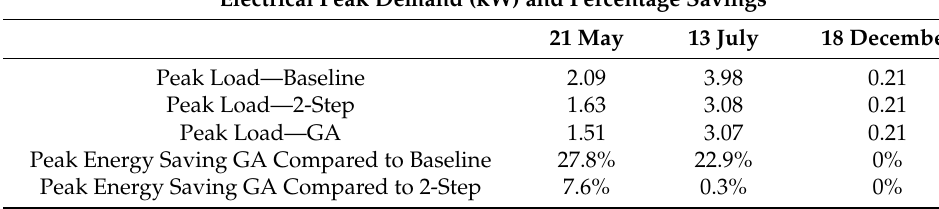
Table 4. Electrical peak demands for baseline STIS–smart windows applied to a house in Golden, CO for three representative days: 21 May (swing season), 13 July (summer season), and 18 December (winter season) using two control strategies.